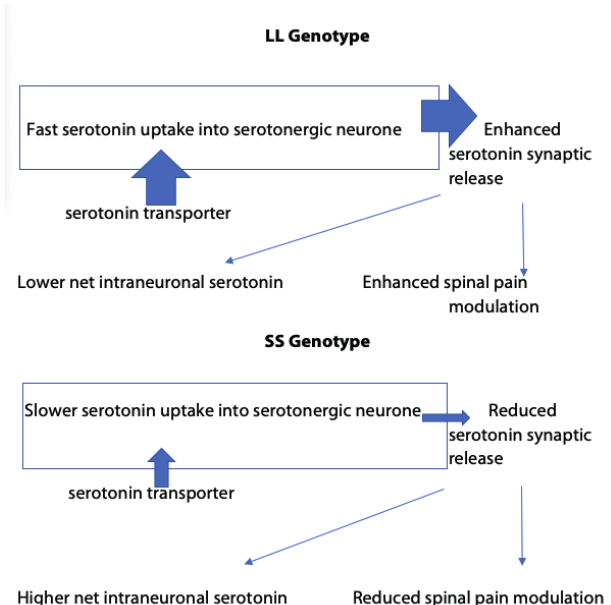
Figure 3. Diagram with hypothesis explaining intraneuronal serotonin levels in genetic